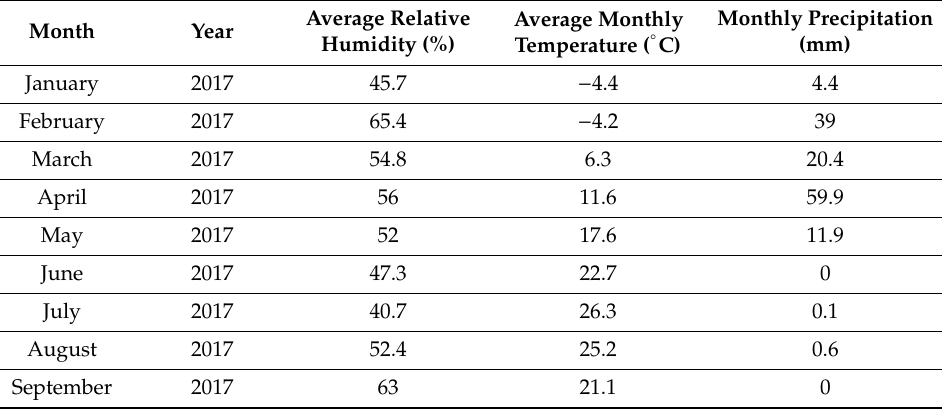
Table 3. The outdoors climatic data of the experimental city